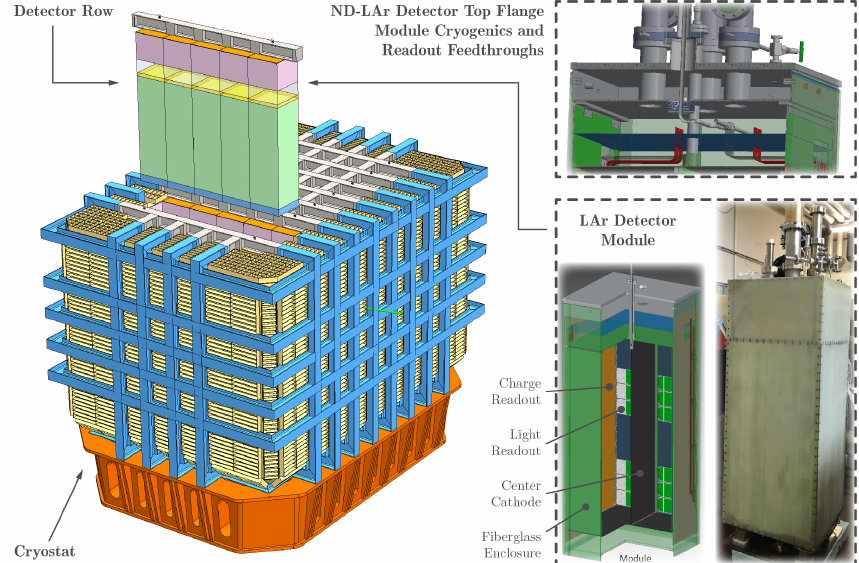
Figure 169. Conceptual image of the ND-LAr subdetector. Seven rows of five pixelated detector modules each are suspended inside a large membrane cryostat. The figure shows prototype module design features which will be adapted to the final cryostat configuration.